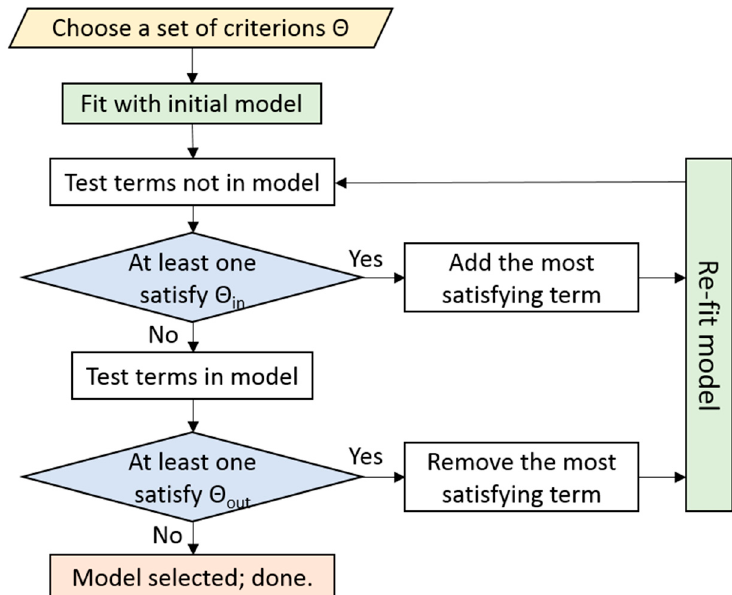
Figure A3. A schematic diagram of stepwise regression. Stepwise regression fits polynomial models iteratively. First, a set of criterions is chosen to determine whether to add terms or remove terms. Then, the fitting starts with an initial model, usually a constant model or a linear model. After that, terms that are not in the model are tested separately. If there is at least one term that satisfies the addition criterion, the most satisfying term will be added into the model, and the renewed model will be fit again. The addition step loops until there is no term not in the model that satisfies the addition criterion. After addition of terms, all the terms in the model are tested with the removal criterion. The removal step is similar to the addition step, but differs in that once a term is removed from the model, the model is fit again, and the regression process is returned to the addition step. The whole regression process ends when there are neither terms that can be added into the model nor terms that can be removed from the model.